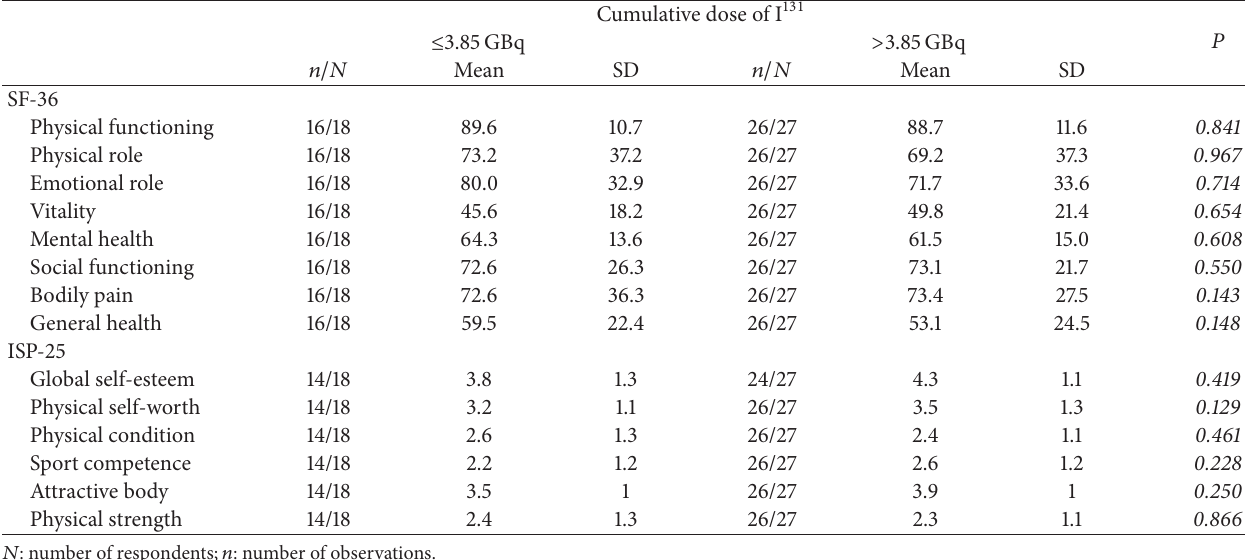
Table 2: Long-term quality of life and global self-esteem of patients diagnosed with differentiated thyroid cancer before age of 25 years.